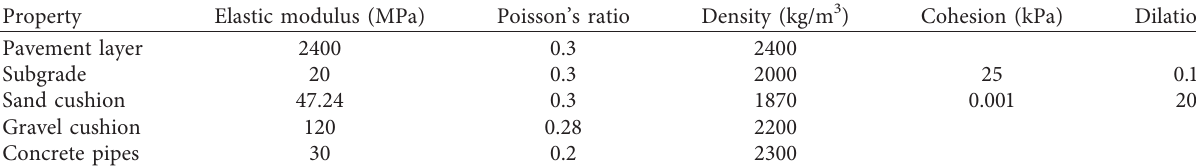
Table 1: Property of materials in numerical analysis.